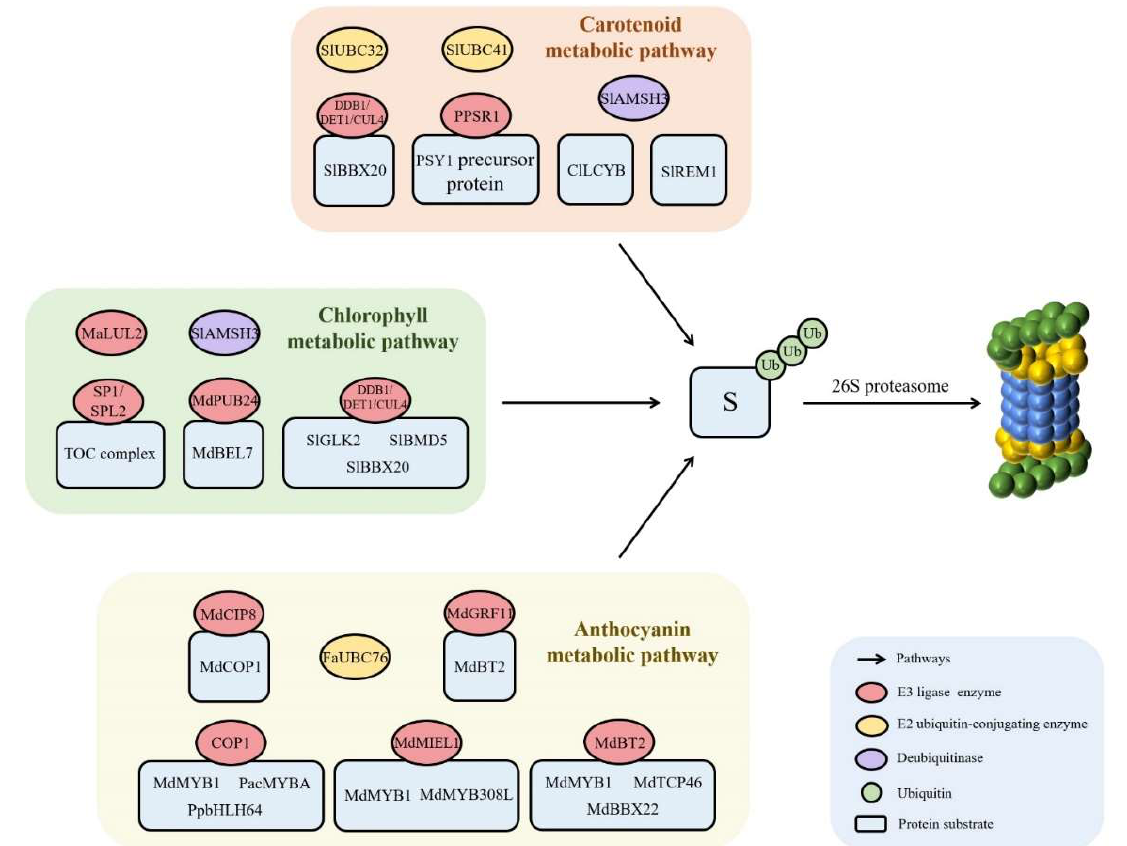
Figure 3. The function of the ubiquitin–26S proteasome pathway in pigment metabolism. S: sub- strate proteins, such as SlBBX20, PSY1 precursor protein, ClLCYB, SlREM1, TOX complex, MdBEL7, SlGLK2, SlBMD5, MdCOP1, MdBT2, MdMYB1, PacMYBA, PpbHLH64, MdMYB308L, MdTCP46, and MdBBX22.